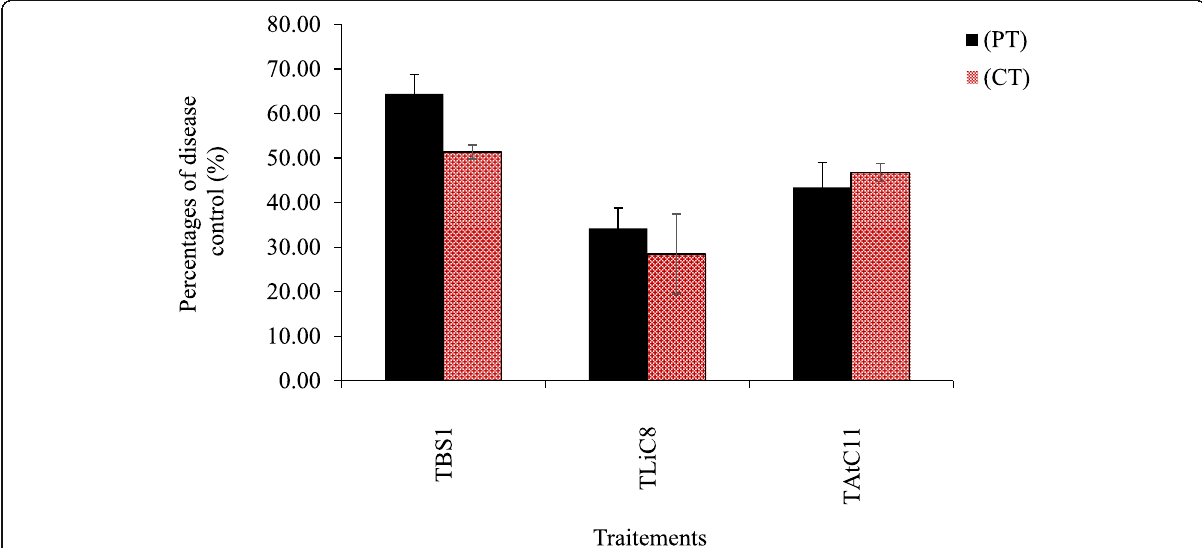
Fig. 6 Protection of tomato plants against B. cinerea isolate (BCT04) revealed by three isolates of Trichoderma spp. (TBS1, TAtC11, TLiC8). Tests were carried out on 30-day-old tomato plants (Kawa variety). Two modalities of treatment were applied, preventive treatment (PT), and curative treatment (CT). The values correspond to the mean of 30 replicates